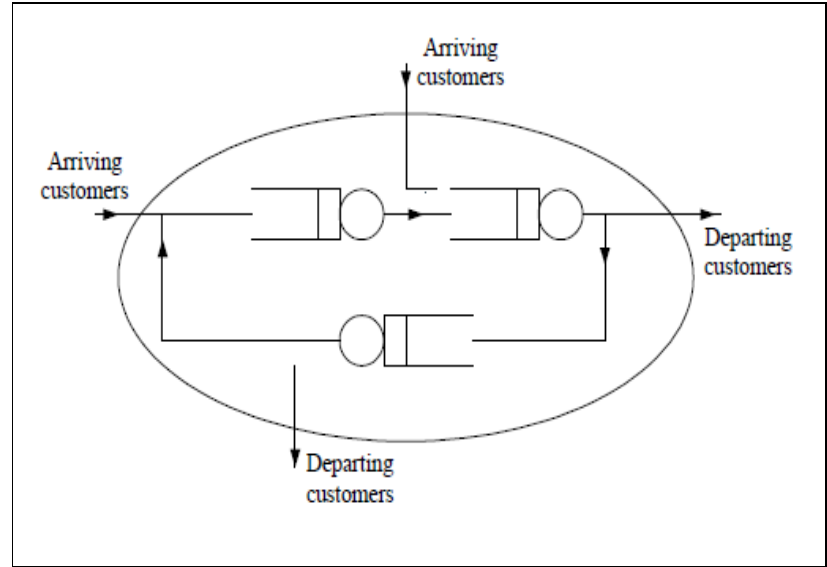
Figure 2. Queueing network model.